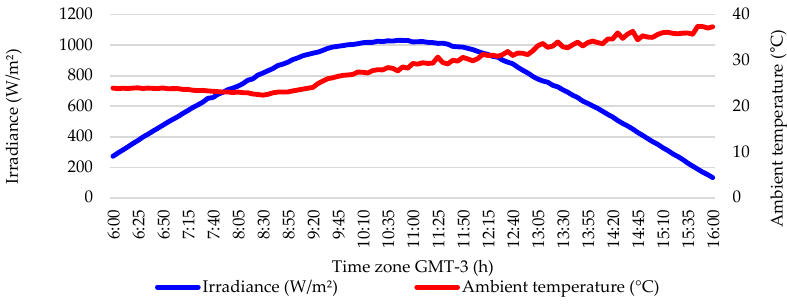
Figure 8. Normal condition.